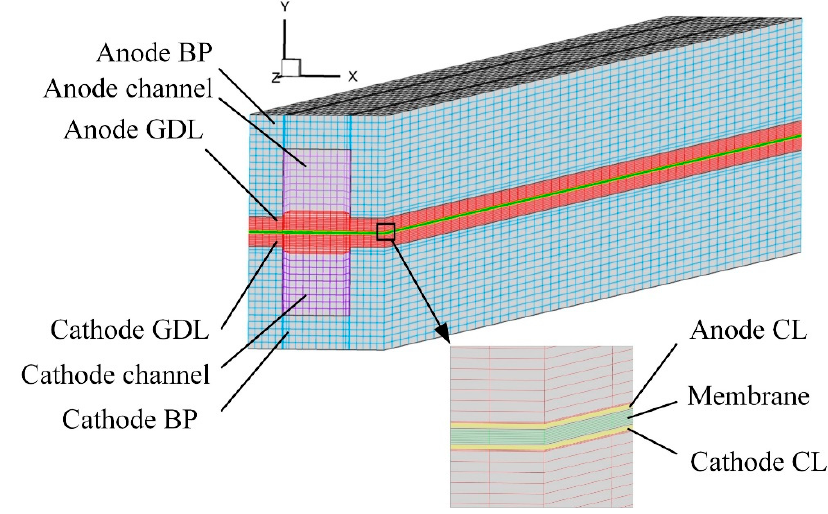
Figure 3. Computational domain of the CFD model.